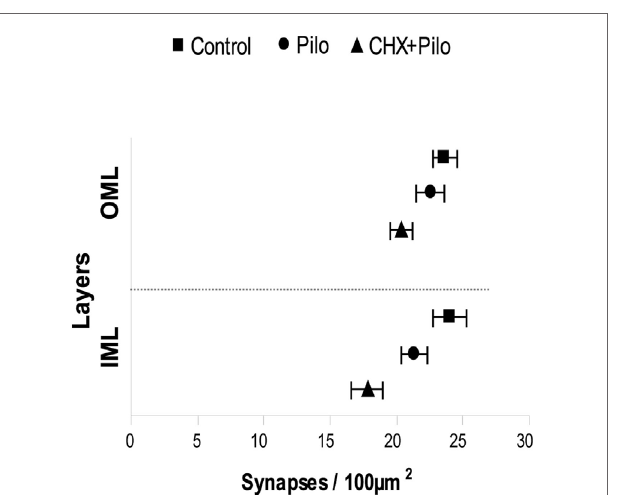
FigUre 4 | Means and 95% confidence interval of the total number of synapses obtained using six photomicrographs per layer (iMl and OMl) in five animals per group . IML, inner molecular layer; OML, outer molecular layer.